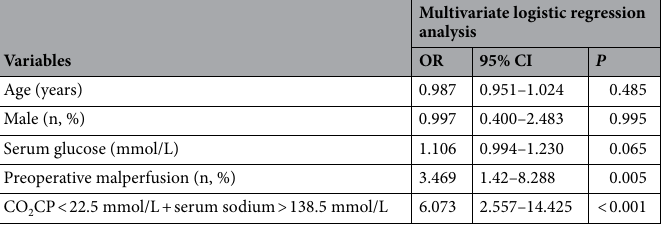
Table 5. Independent predictors of mortality in multivariate logistic regression analysis.